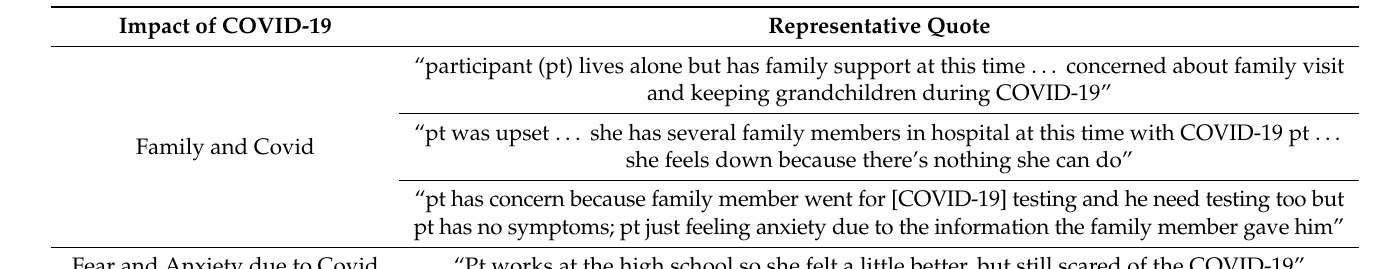
Table 5. Impact of COVID-19 on Support Structures, Resource Access, and